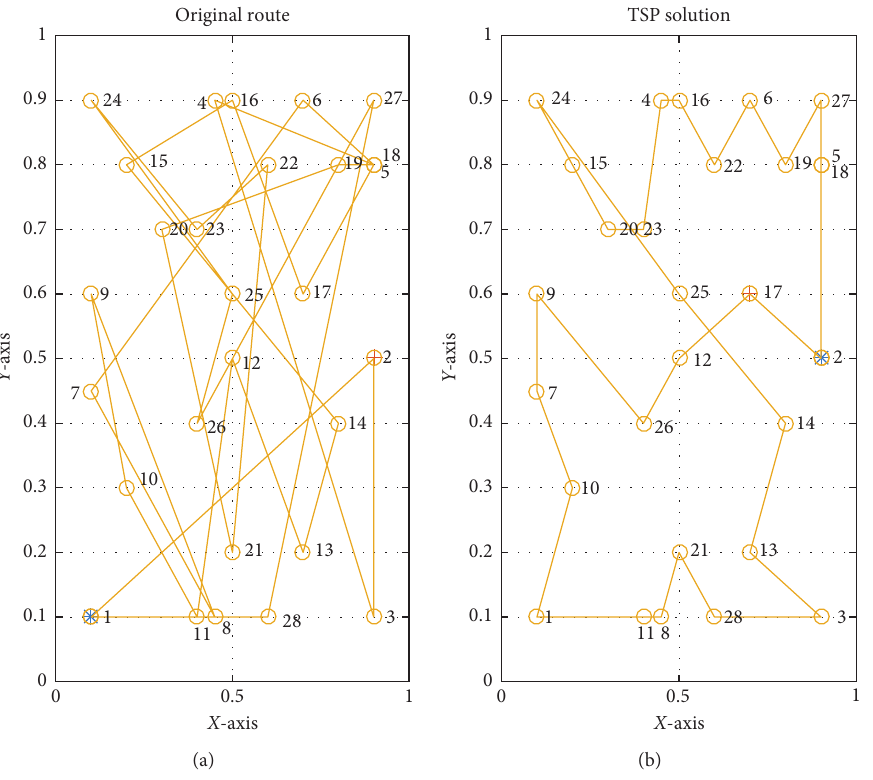
Figure 9: The solution of TSP.